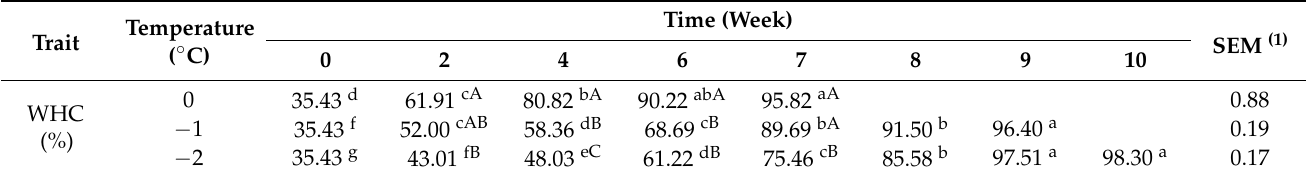
Table 4. WHC of dry-aged beef loin on 0, − 1, − 2 ◦ C temperature electric field refrigerate